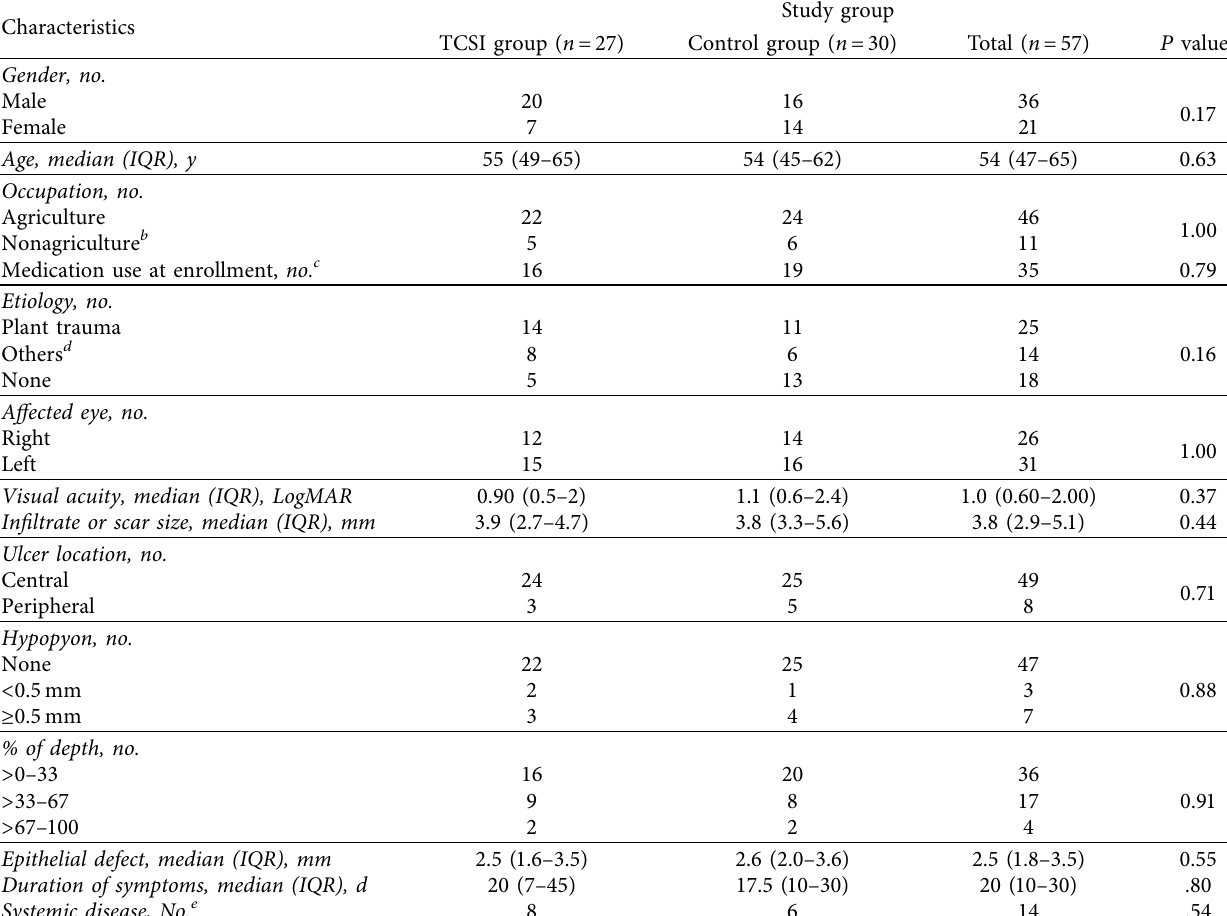
Table 1: Baseline demographic and clinical characteristics.